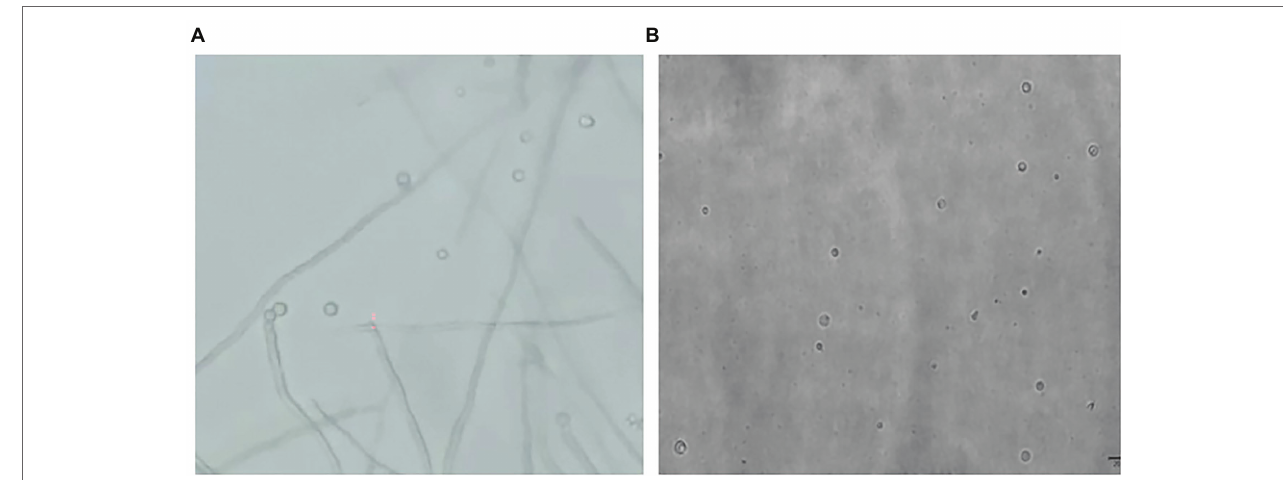
FIGURE 5 | The process of protoplasts releasing (A) and morphology (B) of strain